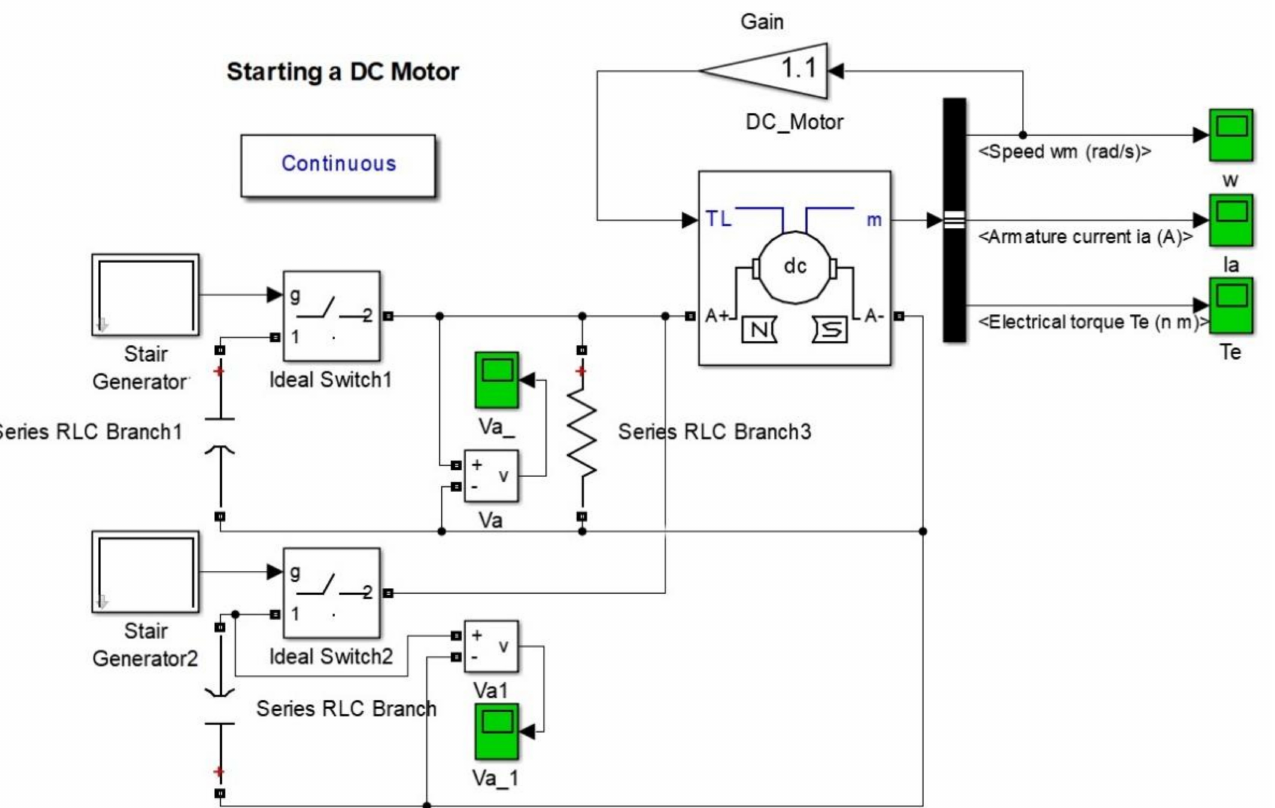
Figure 8. Model structure for checking the linear current